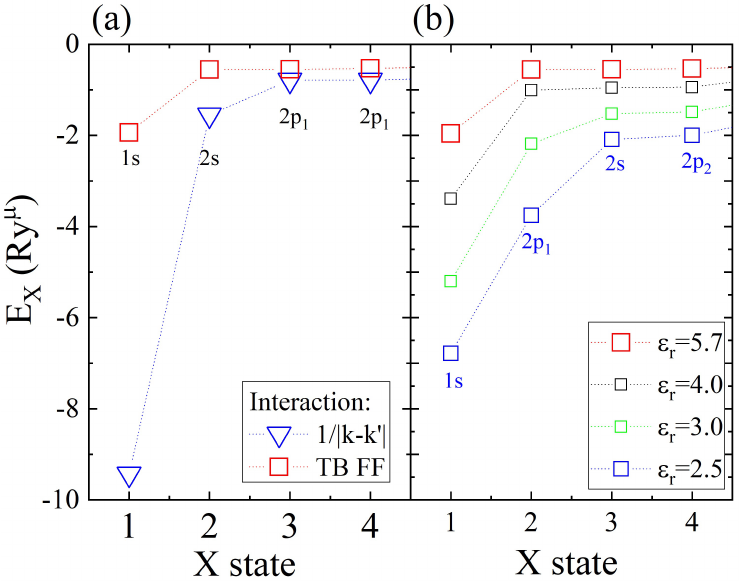
Figure 11. The first two shells of the excitonic spectrum with full tight-binding direct interaction form factors. ( a ) Effect of the form factors compared to F D = 1 approximation. ( b ) Effect of different static screening on the spectrum. On both ( a , b ), tight-binding energies of electron and hole are